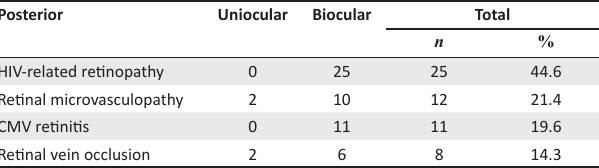
TABLE 6 : Ophthalmic manifestations in posterior segment of human immunodeficiency virus and acquired immunodeficiency syndrome participants in this study ( n = 56).